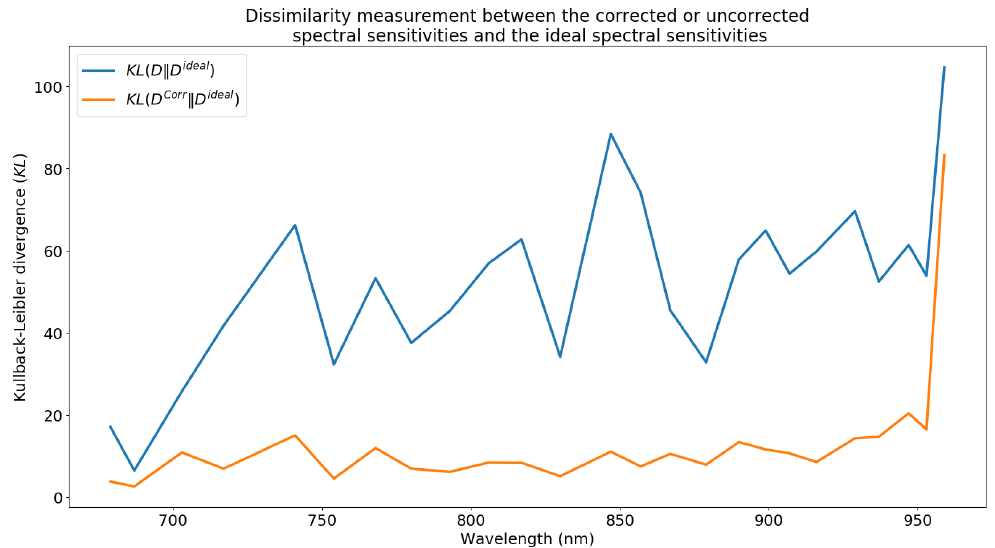
Figure 3. Measure of dissimilarities between the corrected (in orange) or uncorrected (in blue) spectral sensibilities and the ideal spectral